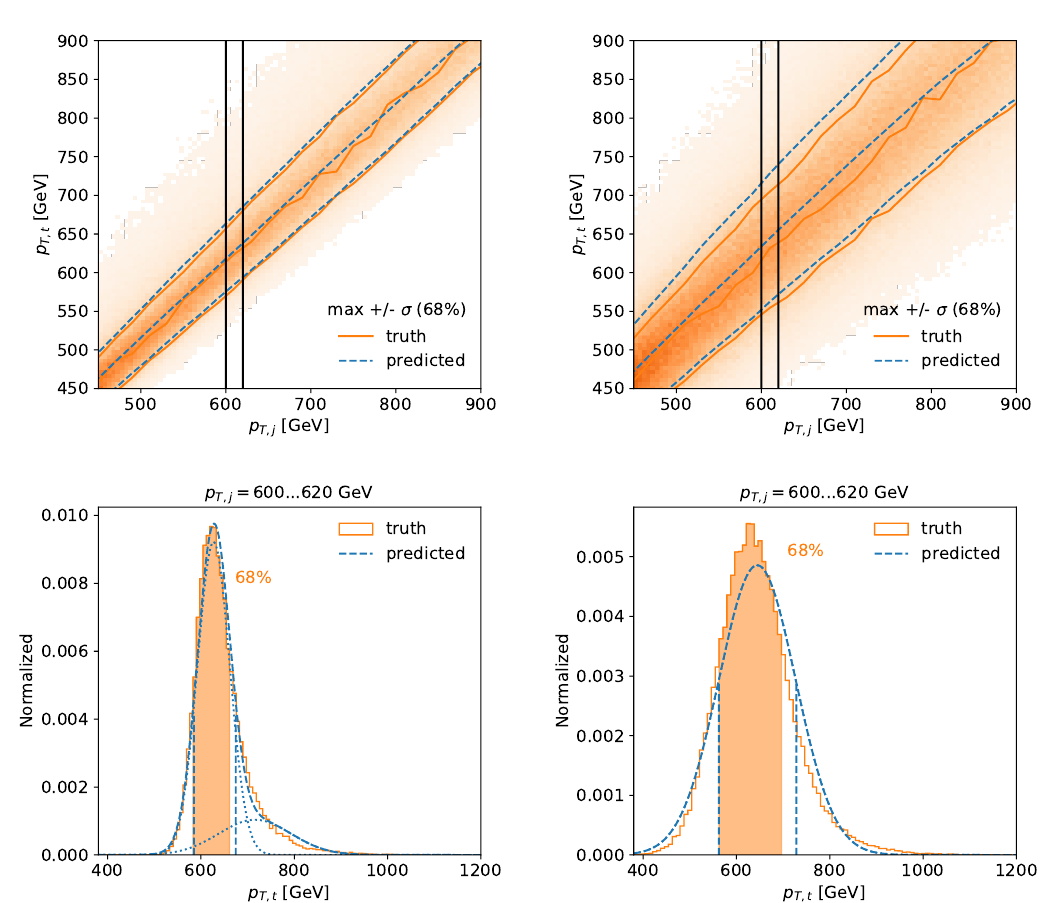
Figure 9: Upper: 2-dimensional distribution of p truth around the maximum, after adding 4% (left) and 10% (right) Gaussian noise on the top momentum label. In blue we also show the BNN error estimate. Lower: corresponding p truth -distribution for a narrow slice in p T , t